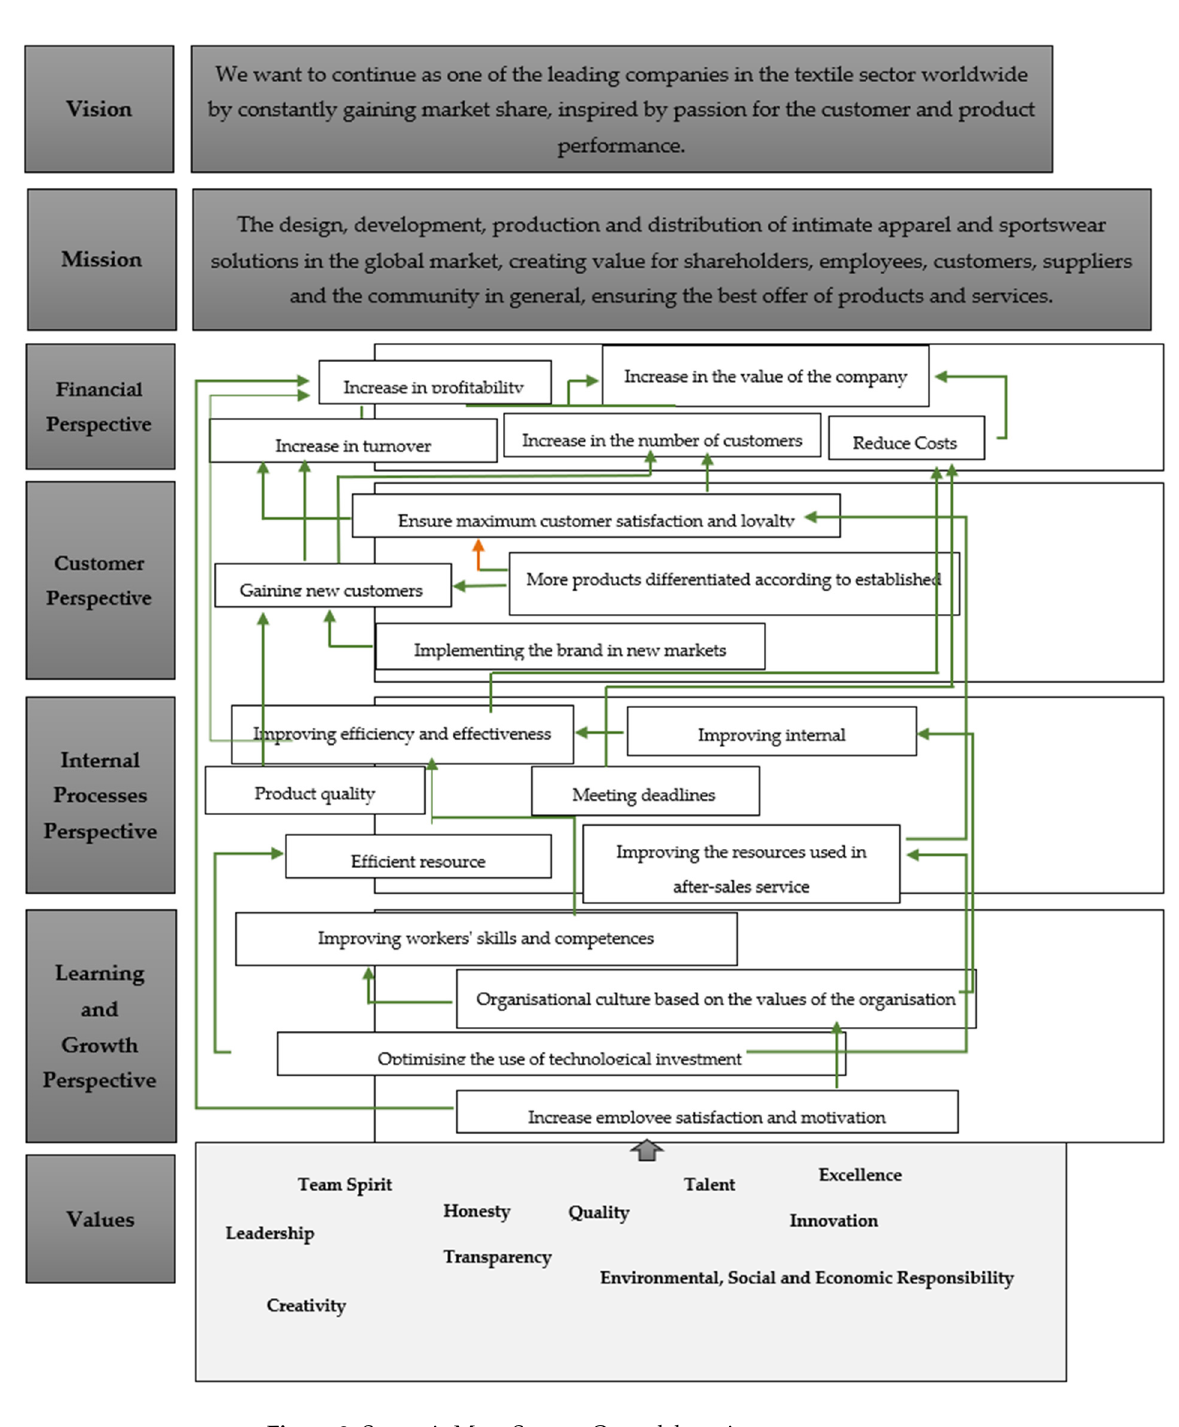
Figure 3. Strategic Map. Source: Own elaboration.